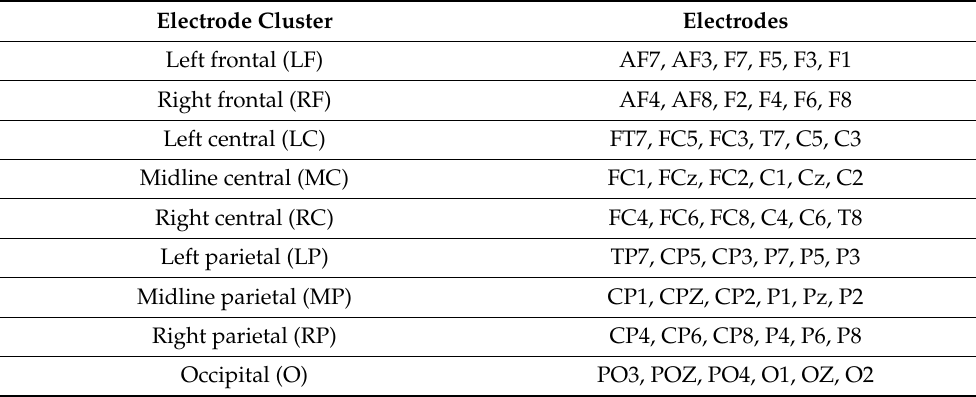
Table 1. Nine electrode clusters, defined from previous auditory-related research, were used to investigate channel-related differences in neural entrainment to